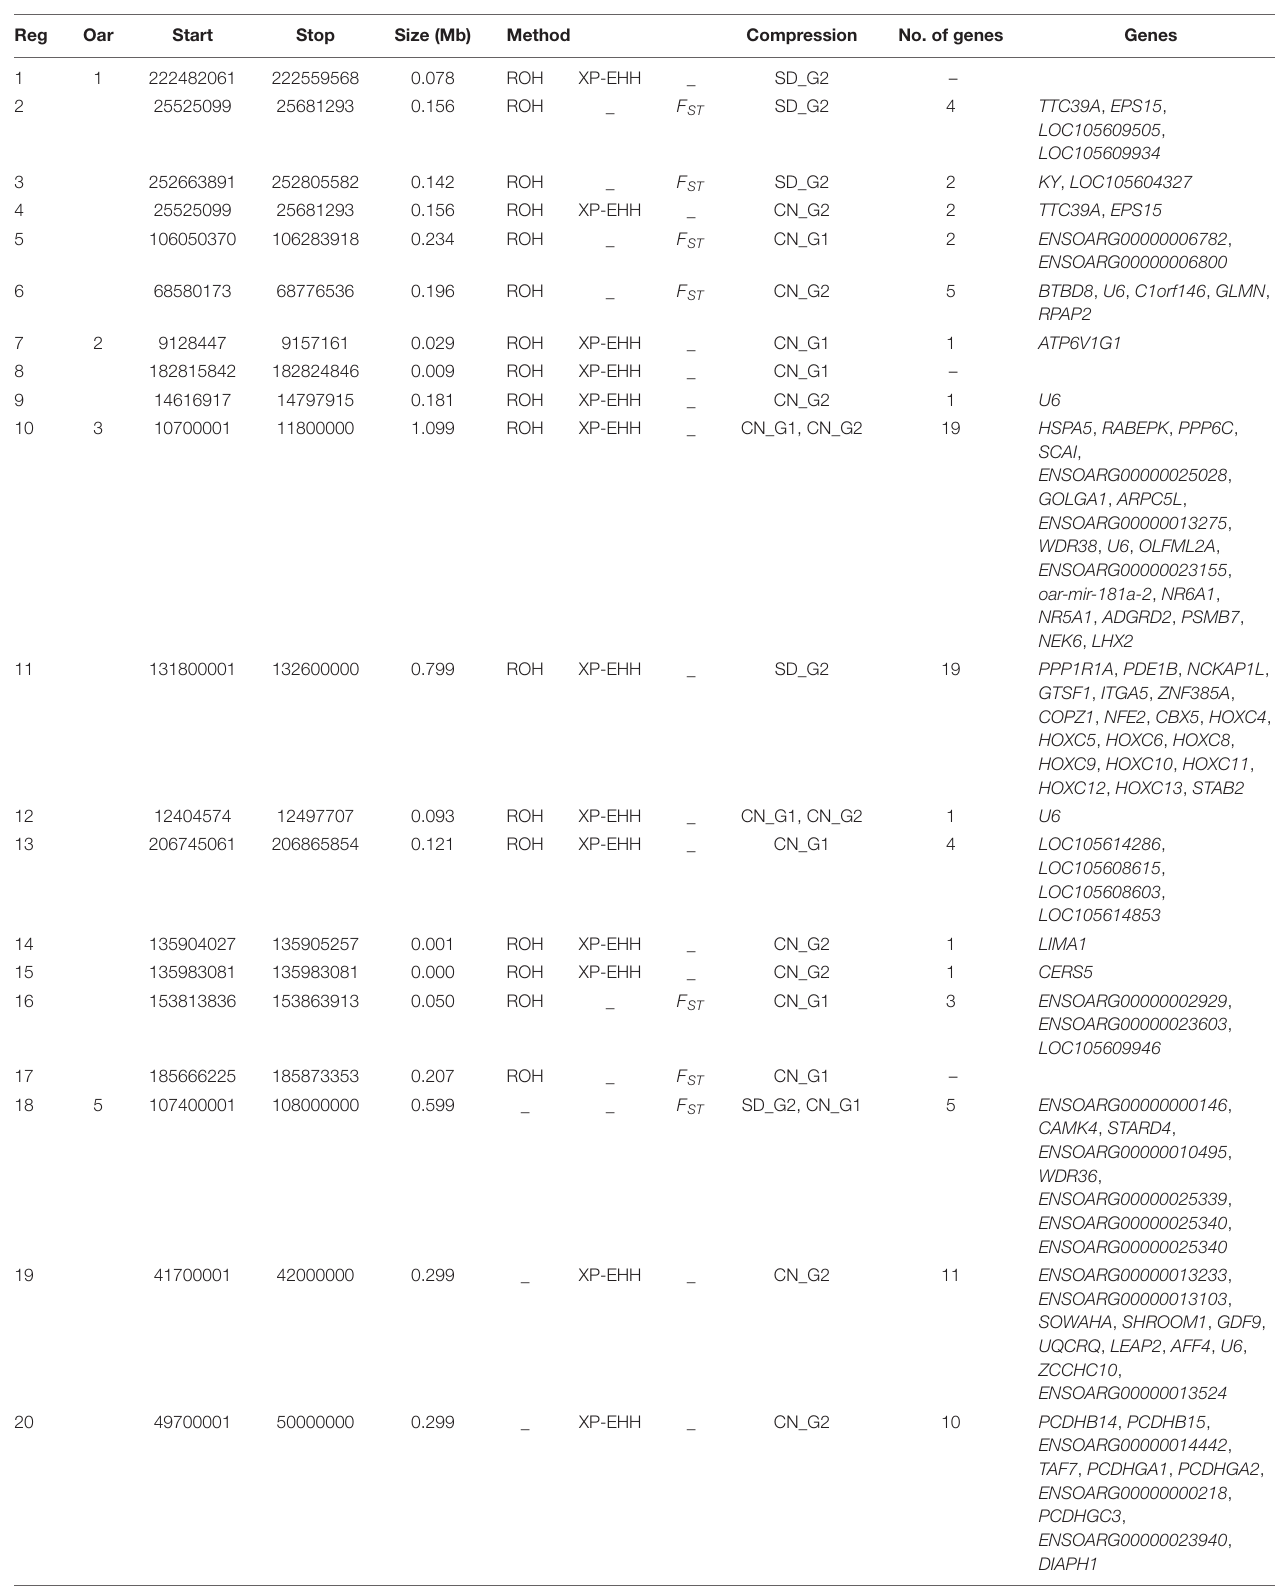
TABLE 2 | Candidate regions detected by at least two approaches of selection signature analysis in the SD_G1 (AL) sheep group. Reg